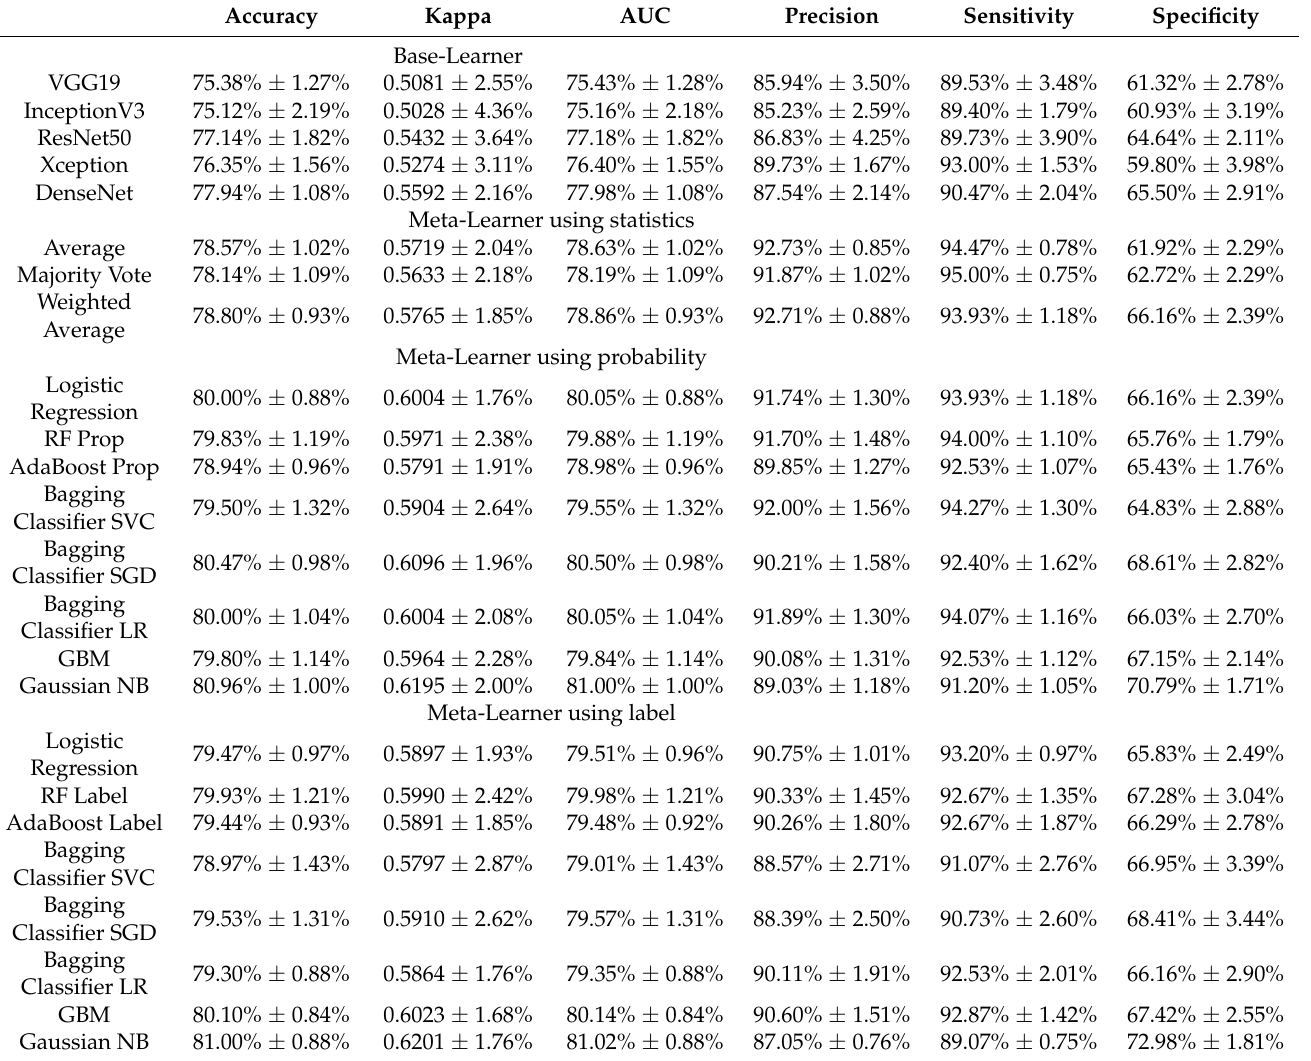
Table A5. The Kappa score achieved by each classifier for the forearm images ( ± Confidence Interval 95%). Test performance is